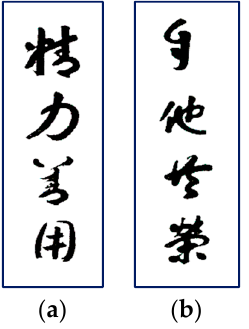
Figure 2. Seyryoku Zenyo ( a ) and Jita Kyoei ( b ).